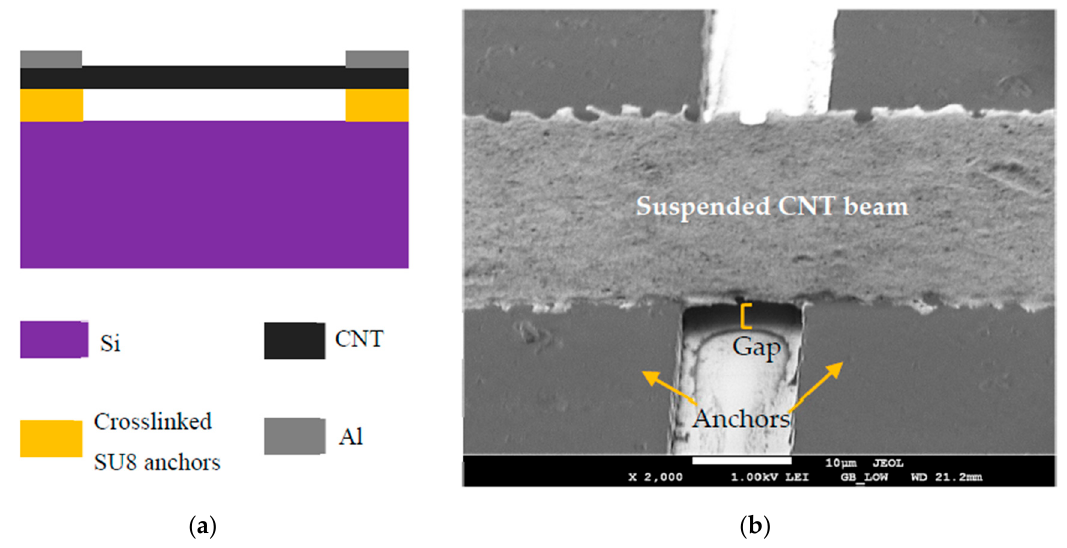
Figure 1. ( a ) Schematic of the suspended CNT beam ( b ) SEM micrograph.